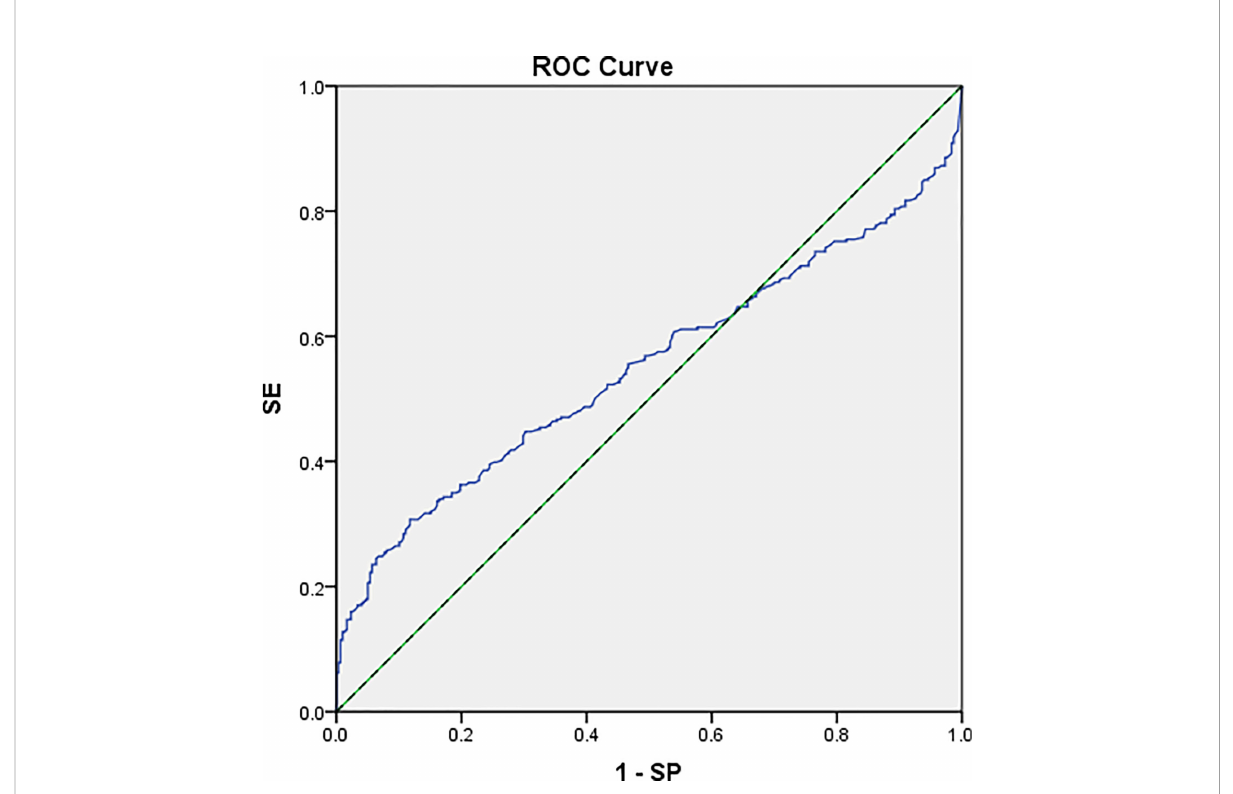
FIGURE 4 The ROC curve of using a short diameter as the diagnostic index. AUC = 0.552 (95% CI: 0.503 – 0.597).